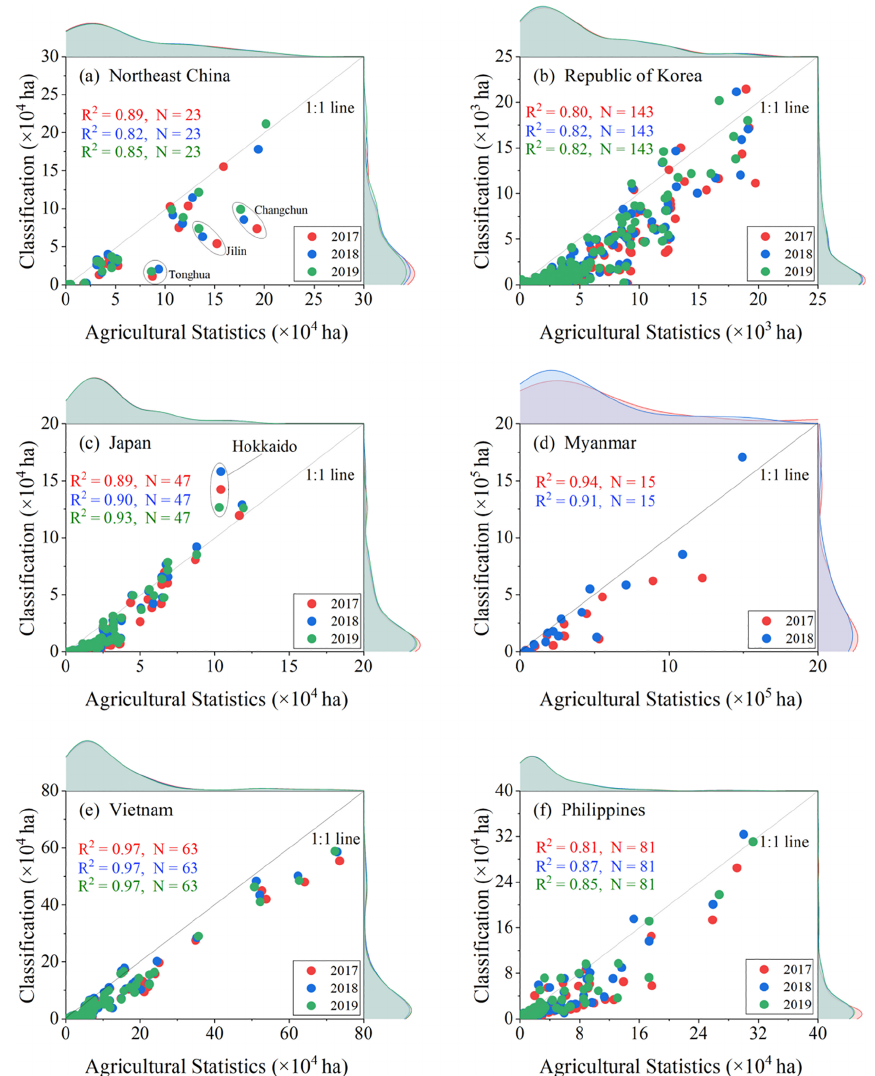
Figure 4. Comparison of the resultant annual paddy rice areas and the agricultural statistics at the subnational level in different countries from 2017 to 2019. The marginal kernel density plot above or to the right of each scatterplot shows the distribution of the data in one